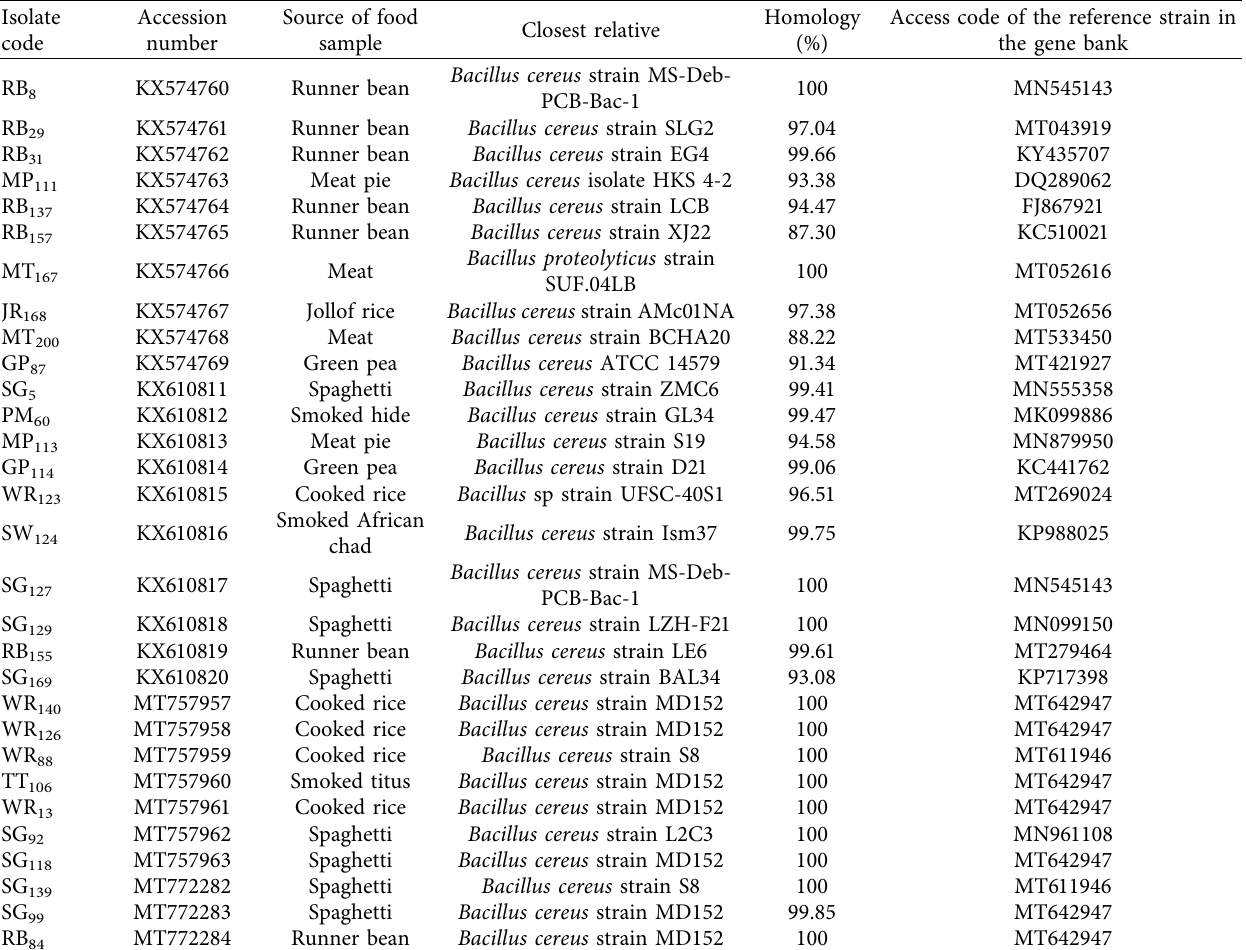
Table 1: B. cereus isolates accession number and the source of the